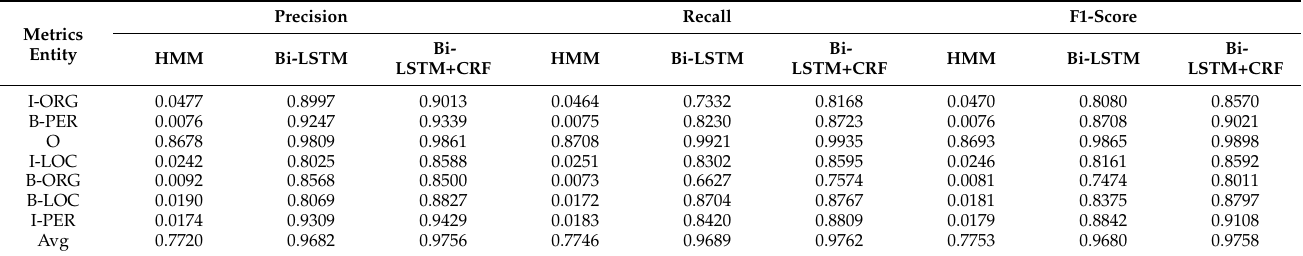
Table 4. The experimental results of Chinese